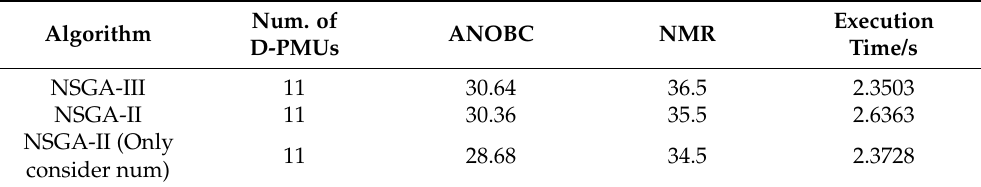
Table 1. Comparison of results based on different